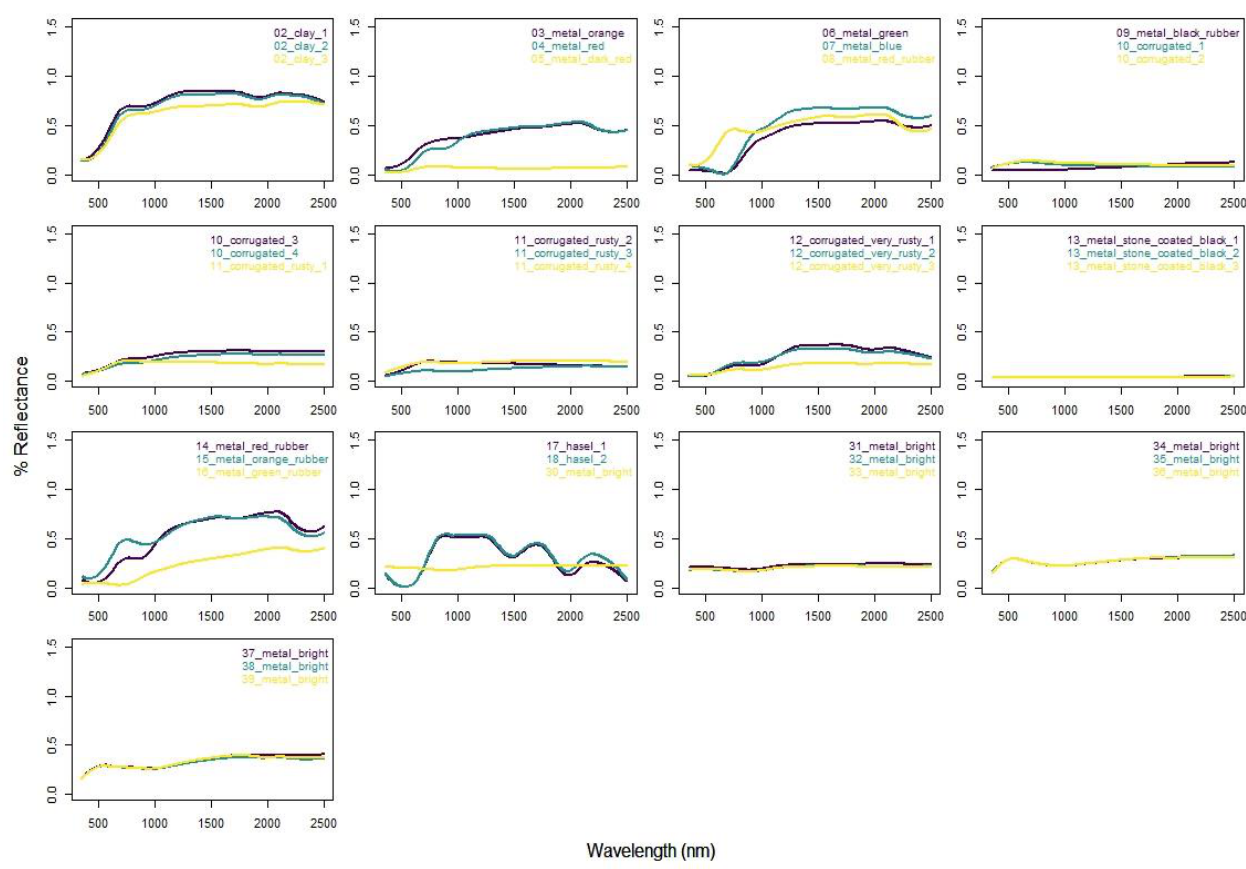
Figure 5: Spectral curves in groups of 3